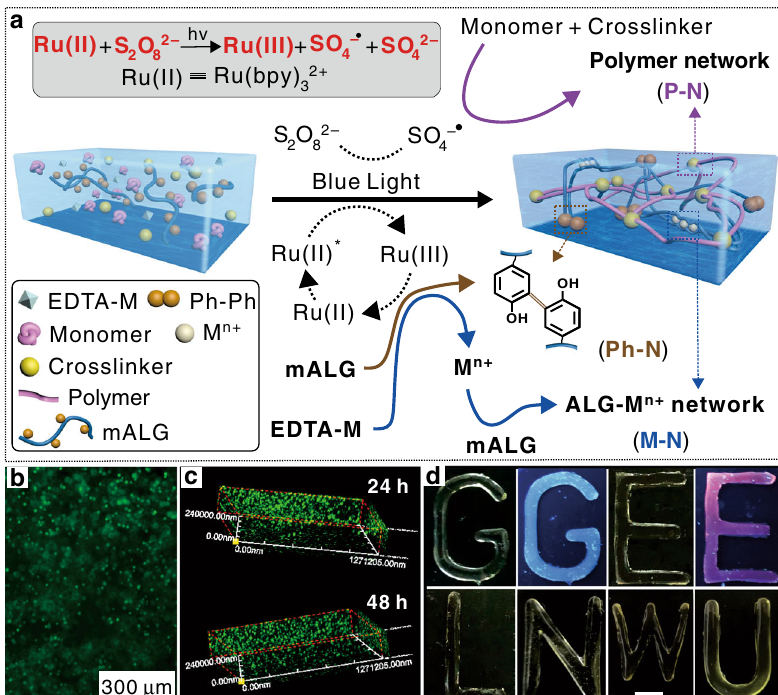
Fig. 1 One-step fabrication of THVMD hydrogels. a The proposed schematic illustration for preparing tough hydrogels. b Fluorescent image of propidium iodide and fl uorescein diacetate co-staining cells in the solution after irradiation. c Confocal fl uorescent images of cells after 24 and 48 h incubation in hydrogels. d THVMD hydrogels under daylight and UV light irradiation. Letters of “ G, E and L ” : Hydrogels with different M – N networks of Tb 3 + , Eu 3 + , and Al 3 + , respectively; Letters of “ N, W and U ” : Hydrogels with different P – N networks of PEG, PAAm and PNIPAM, respectively. The scale bar is 1